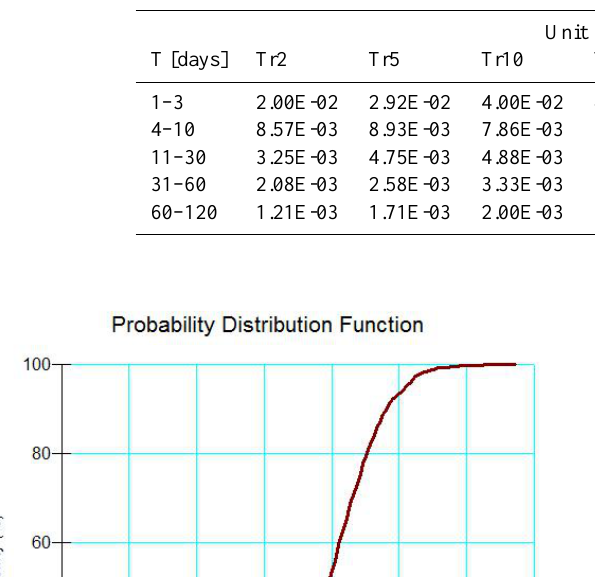
Table 1. Infiltration rate due to rainfall cumulated from 1 to 120 days for return periods of 2, 5, 10, 20, 50, 100, 200yr.